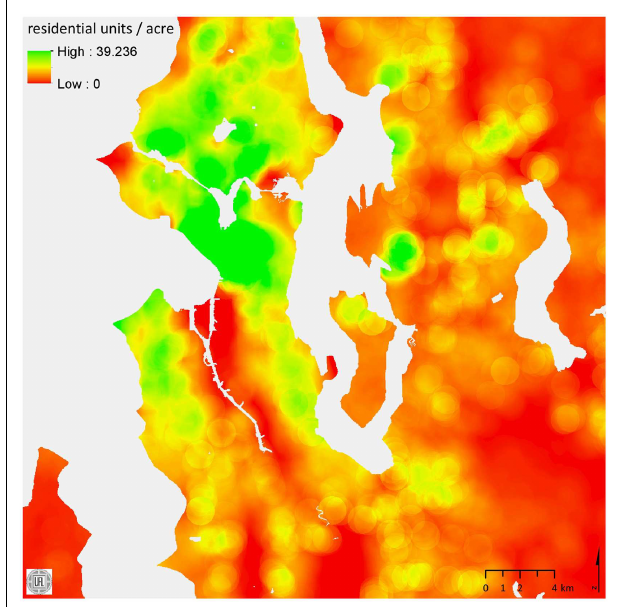
FIGURE 7 |A SmartMap of residential unit density .Values are count of residential units per acre within 833 m of each raster cell.